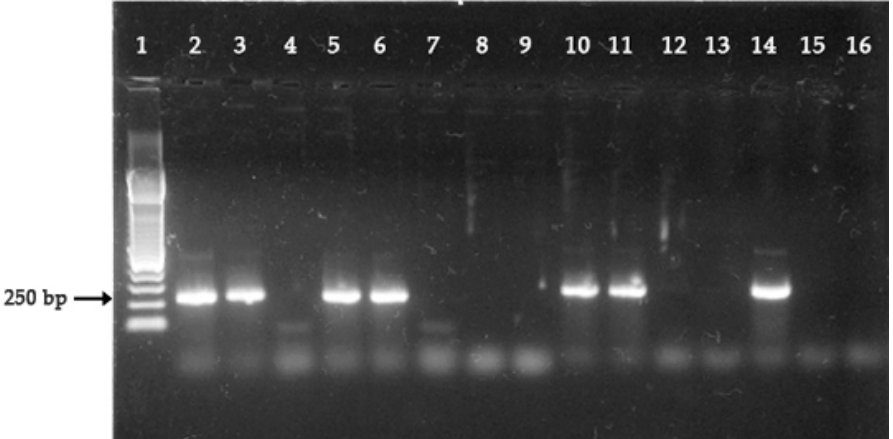
Figure 1. Electrophoretic profile for the molecular analysis of the pfhrp2 gene (exon 2). Numbers: 1 = 100 bp molecular weight marker; 2, 3, 5, 6, 10 and 11 = positive samples for the pfhrp2 gene; 4, 7, 8, 9, 12 and 13 = negative samples; 14 = positive pattern HB3; 15 = negative pattern Dd2; 16 = negative control (sterile distilled water).